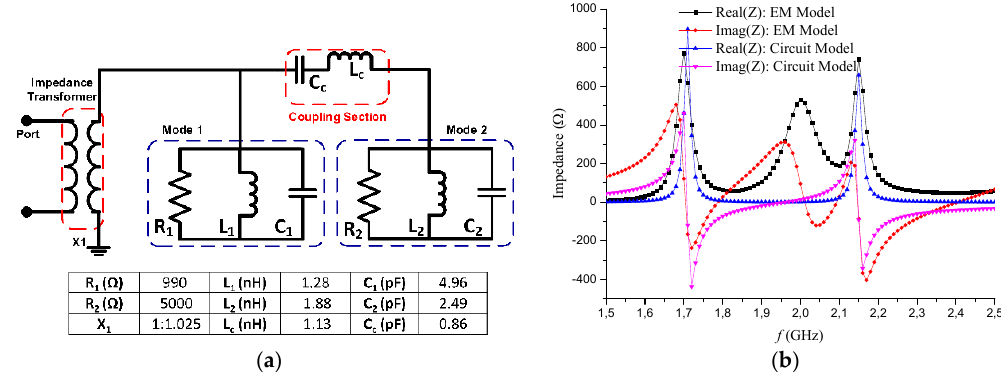
Figure 6. ( a ) Equivalent Circuit Model of the dual-band antenna; ( b ) Impedance comparison of the circuit model and electromagnetic (EM) model.